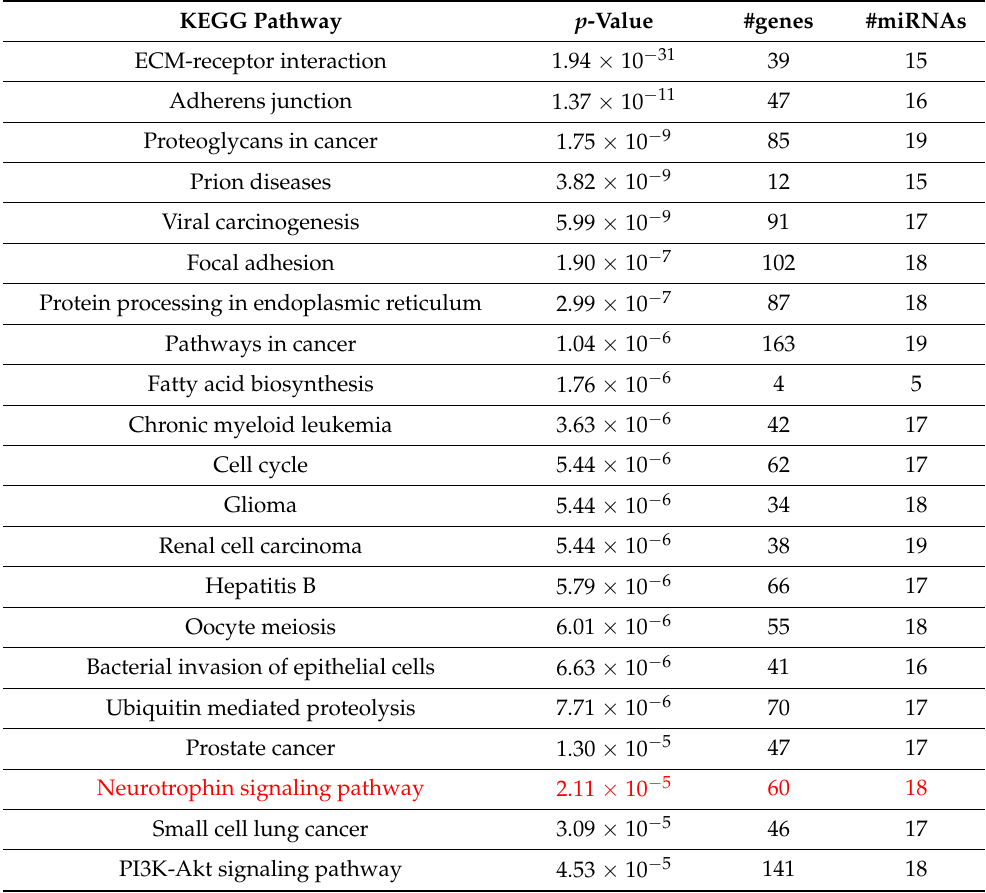
Table 2. DIANA-TarBase pathway analysis in response to rhNGF. KEGG pathways identified by con- sidering significant dysregulated miRNAs (n = 21), as detected by DIANA-TarBase (experimentally supported) analysis. The pathway analyzed in this study is highlighted in